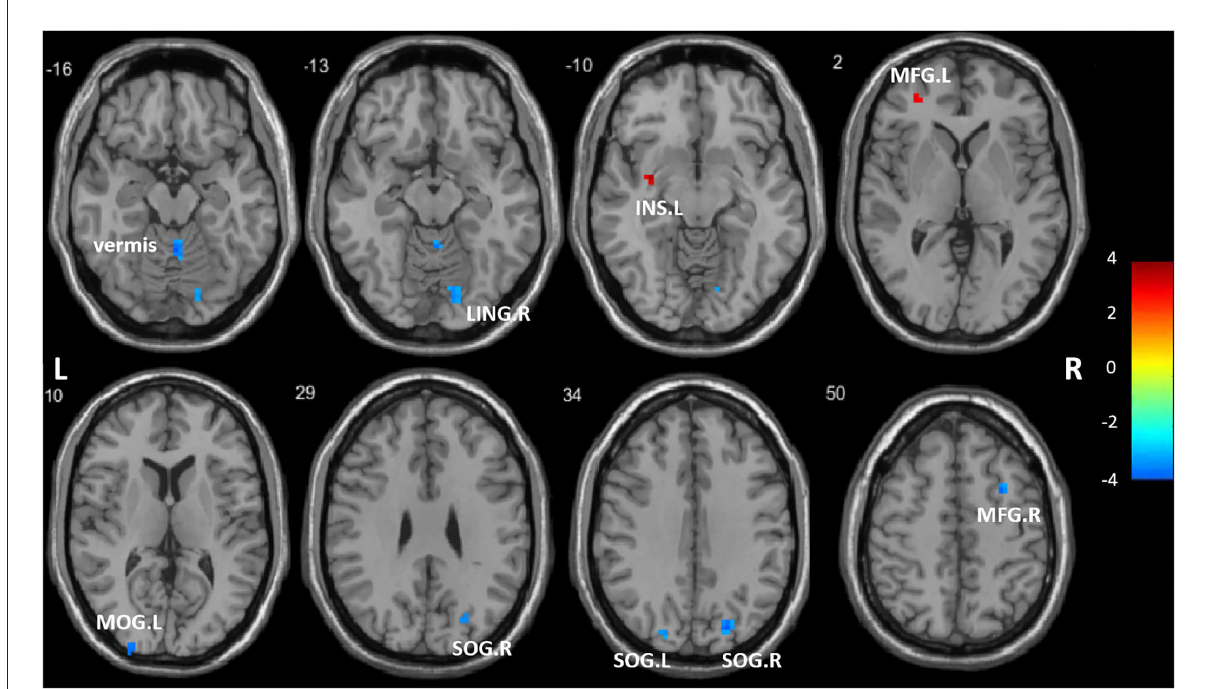
FIGURE1 Regions showing significantly different regional homogeneity (ReHo) between the two groups. LING. R, right lingual gyrus; SOG. R, right superior occipital gyrus; SOG. L, left superior occipital gyrus; MOG. L, left middle occipital gyrus; MFG. R, right middle frontal gyrus; MFG. L, left middle frontal gyrus; INS. L, left insula; vermis. The color bar indicates a scale of T values.